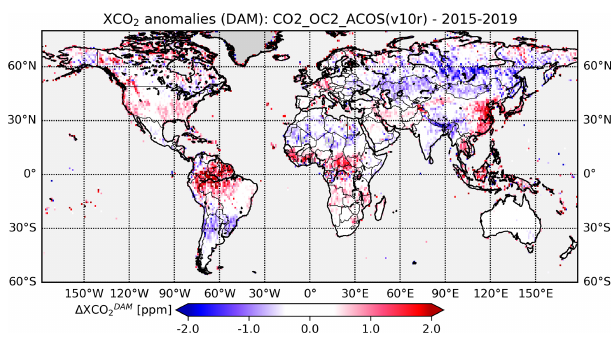
Figure 3. DAM XCO 2 anomaly map at 1 ◦ × 1 ◦ resolution gener- ated from OCO-2 Level 2 XCO 2 (v10r, land) for 2015 to